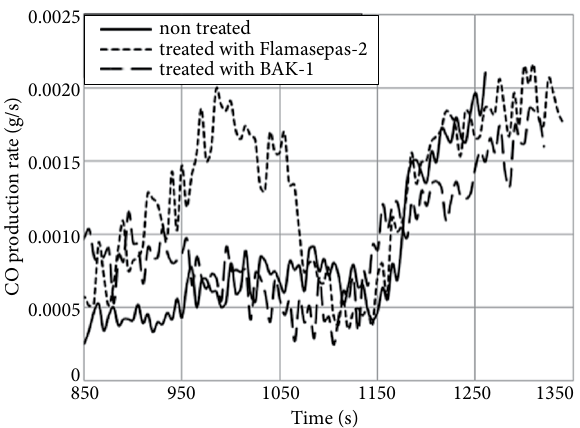
Fig. 8. CO production rate obtained during the first stage of combustion (time interval: 0–200 s) of non-treated and treated specimens in the cone calorimeter at the heat flux of 30 kW/m 2 (with piloted ignition)